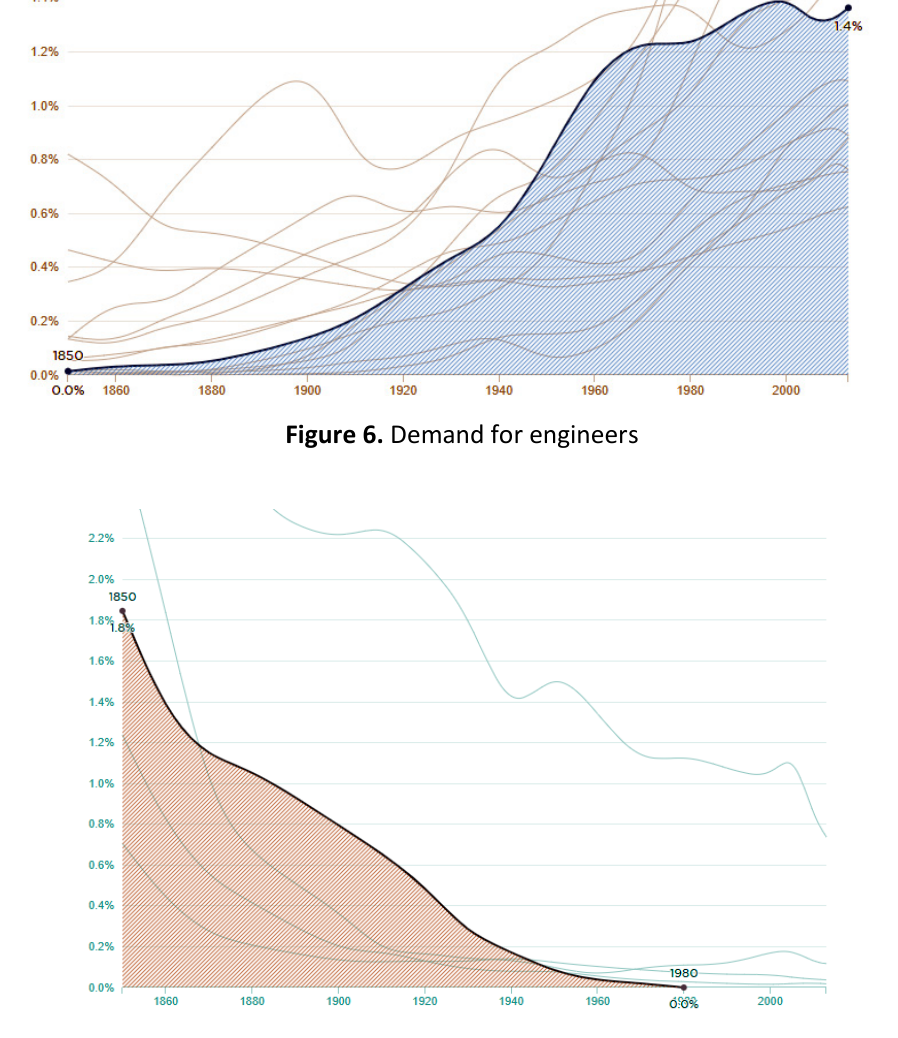
Figure 7. Demand for